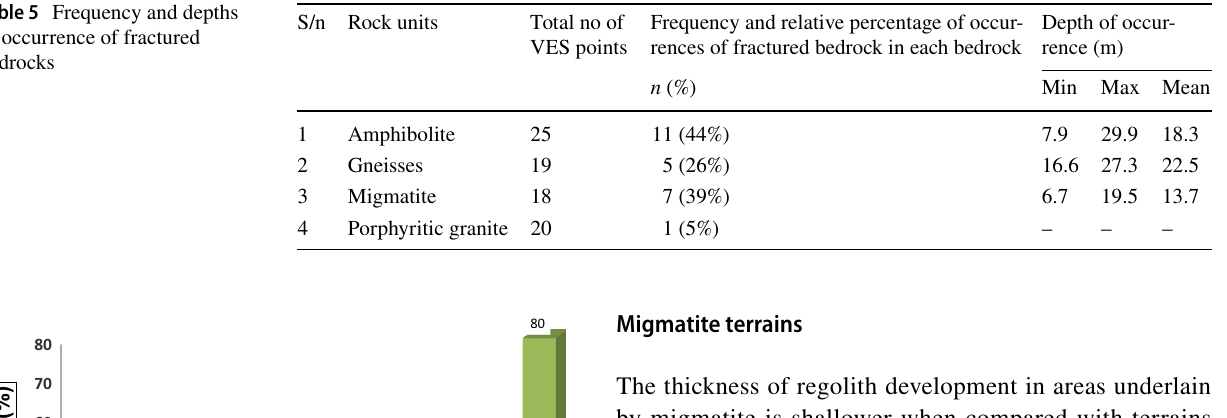
Table 5 Frequency and depths of occurrence of fractured bedrocks